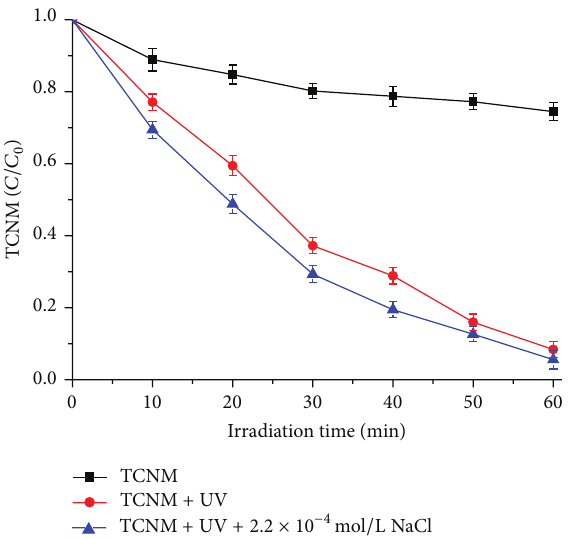
Figure 4: Effect of pH on the photodegradation of TCNM.